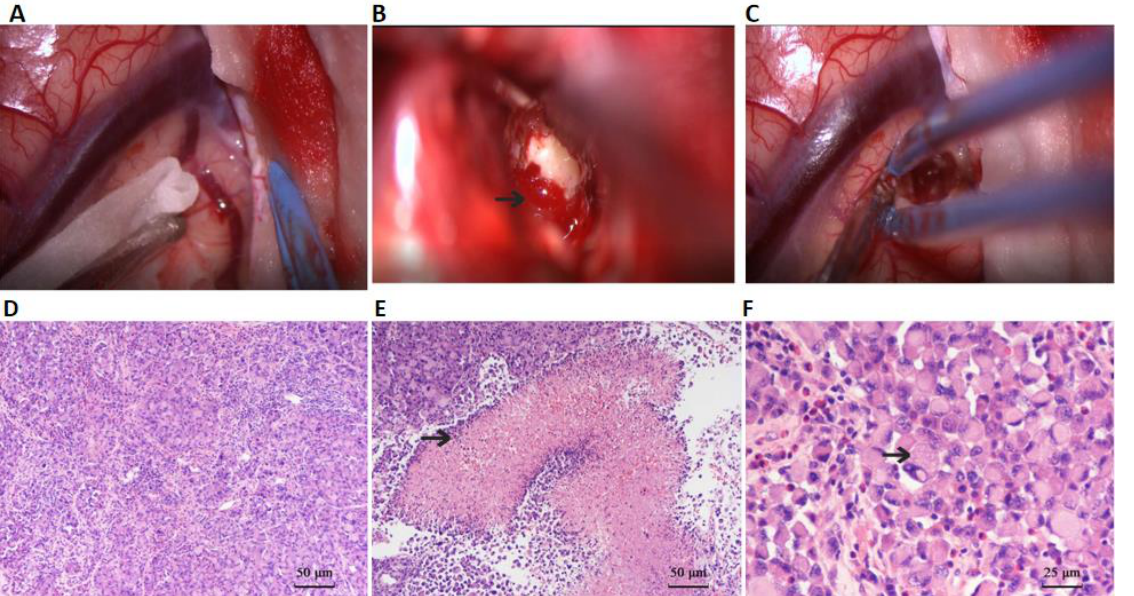
Figure 2. Intraoperative views and postoperative pathological specimens. ( A , C ) Some of the tumors are poorly defined. ( B ) The intraoperative visible tumor size is 20 mm × 10 mm × 20 mm. ( D ) Tumor cell density was significantly increased. ( E ) Extensive necrosis (arrow). ( F ) Plump epithelioid cells with laterally positioned nuclei and abundant cytoplasm (arrow).